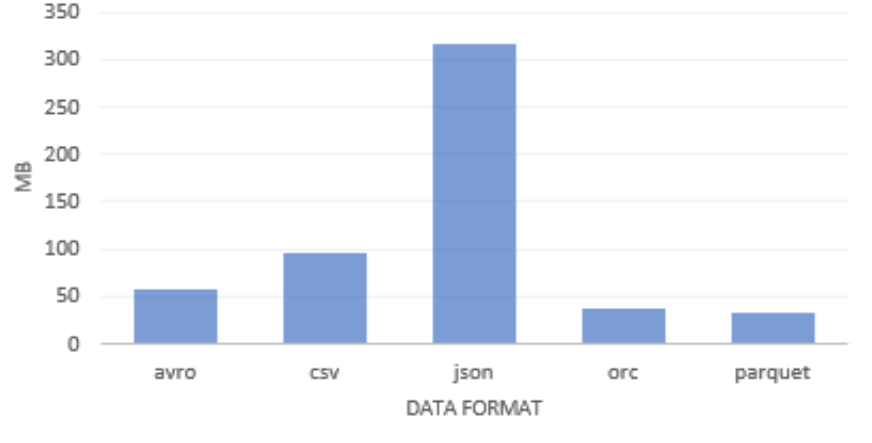
Figure 7. Resulting volume of data.